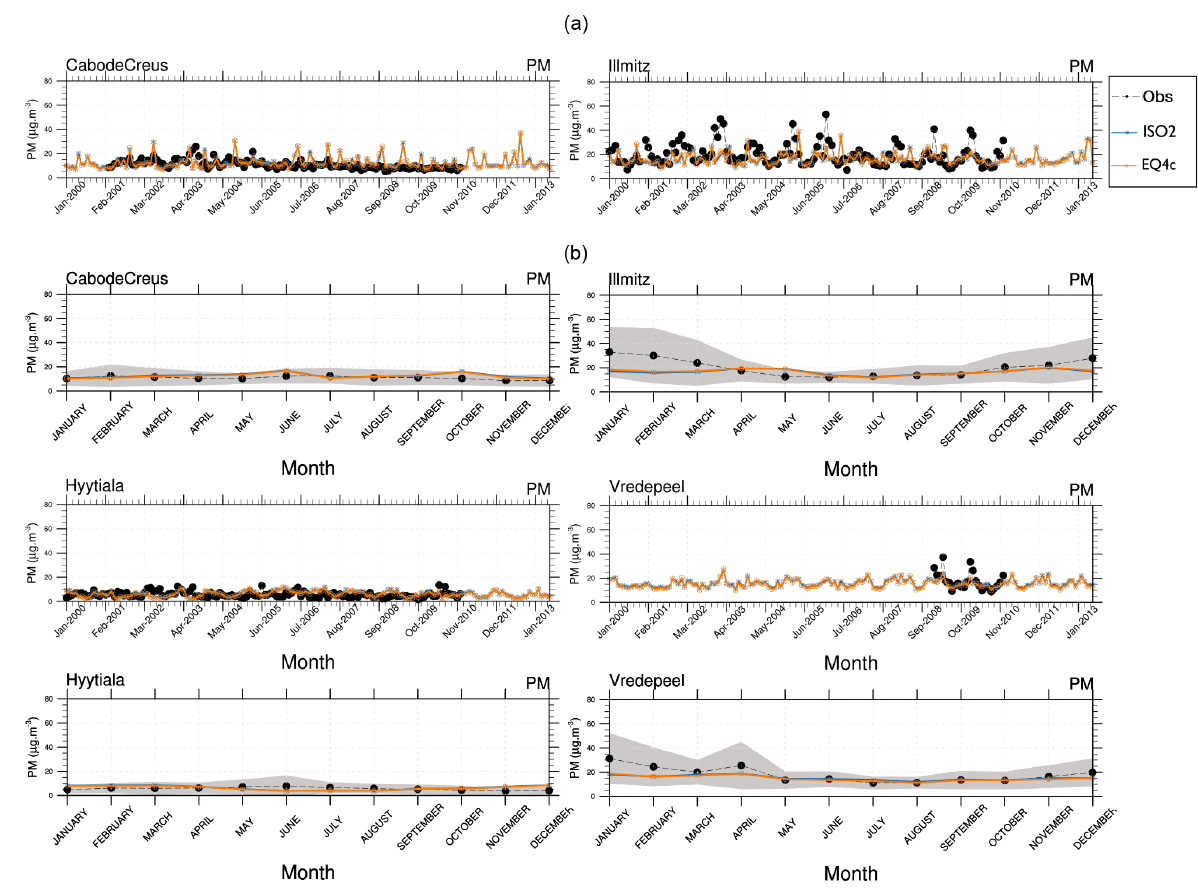
Figure 6. Aerosol mass (PM) time series for 2000–2013 (monthly means): ISORROPIA II (ISO2) and EQSAM4clim (EQ4c) versus EMEP stations, which have long-term observations (a) . The corresponding climatological year (14-year average) is shown below each time